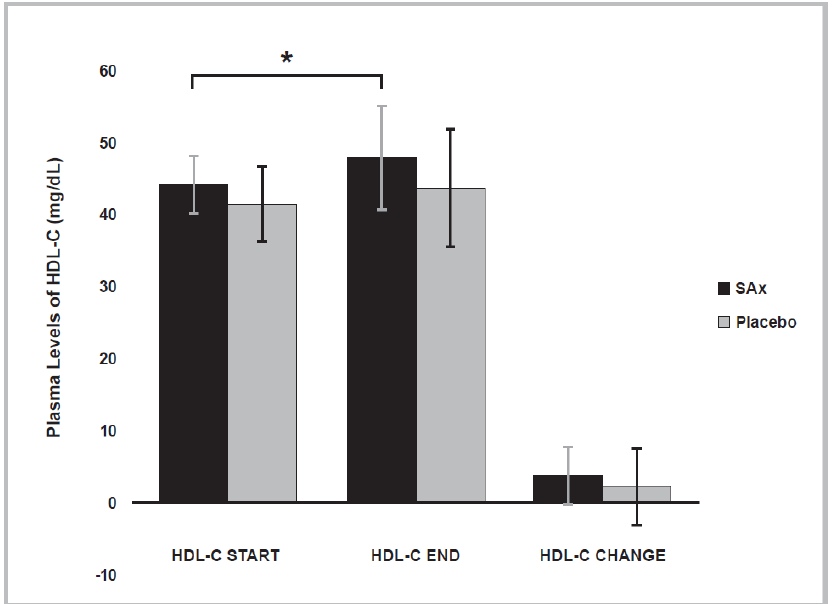
Figure 3. Plasma levels of high-density lipoprotein cholesterol (HDL-C) significantly increased after SAx treatment (oral supplementation with hydroxytyrosol (HT) and punicalagin (PC)) (black color) in subjects with low plasma levels of HDL-C, a risk factor for CVD, ( n = 8) (* p < 0.05). This effect was not observed after placebo treatment (gray color). The data represent the adjusted means ± standard deviations (SDs) from multivariate models. At the end of the SAx period, a significant decrease in the plasma levels of TG was observed in subjects with hypertriglyceridemia (≥ 150 mg/dL) (SAx period start: 200.67 ± 51.38; end: 155.33 ± 42.44 mg/dL; p < 0.017). This significant effect on the plasma levels of TG was not present after the placebo period in these subjects (Placebo period start: 186.00 ± 51.54; end: 170.50 ± 50.32 mg/dL; p < 0.700) (Figure 4).